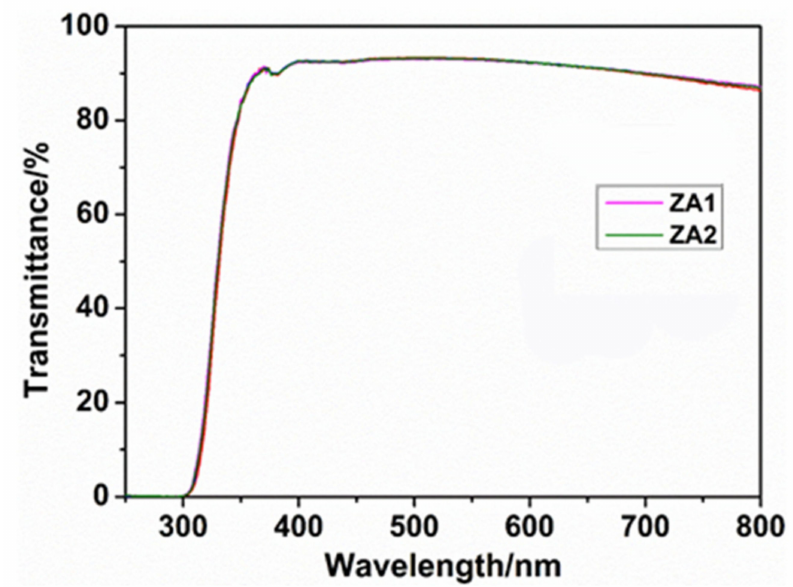
Figure 15. Transmittance curve of ZA1 and ZA2 composite coating.